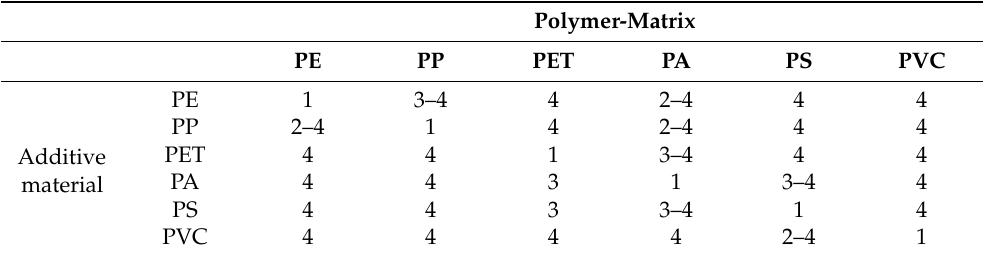
Table 2. Miscibility of different polymers, based on [80]. Abbreviations used: PS (polystyrene), PVC (polyvinyl chloride).